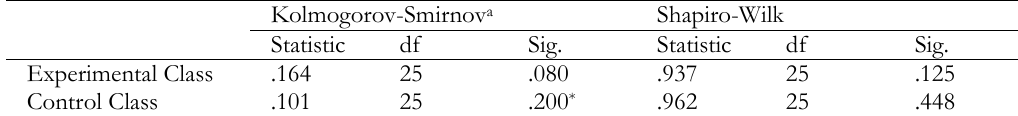
TABLE 1. Tests of Normality (Pre-test)